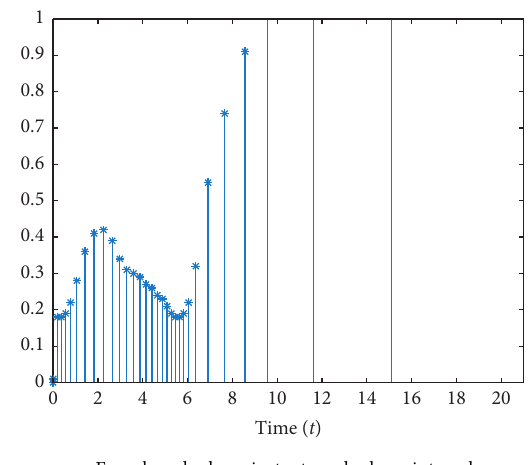
Figure 10: Event-triggered release instants and intervals of The- orem